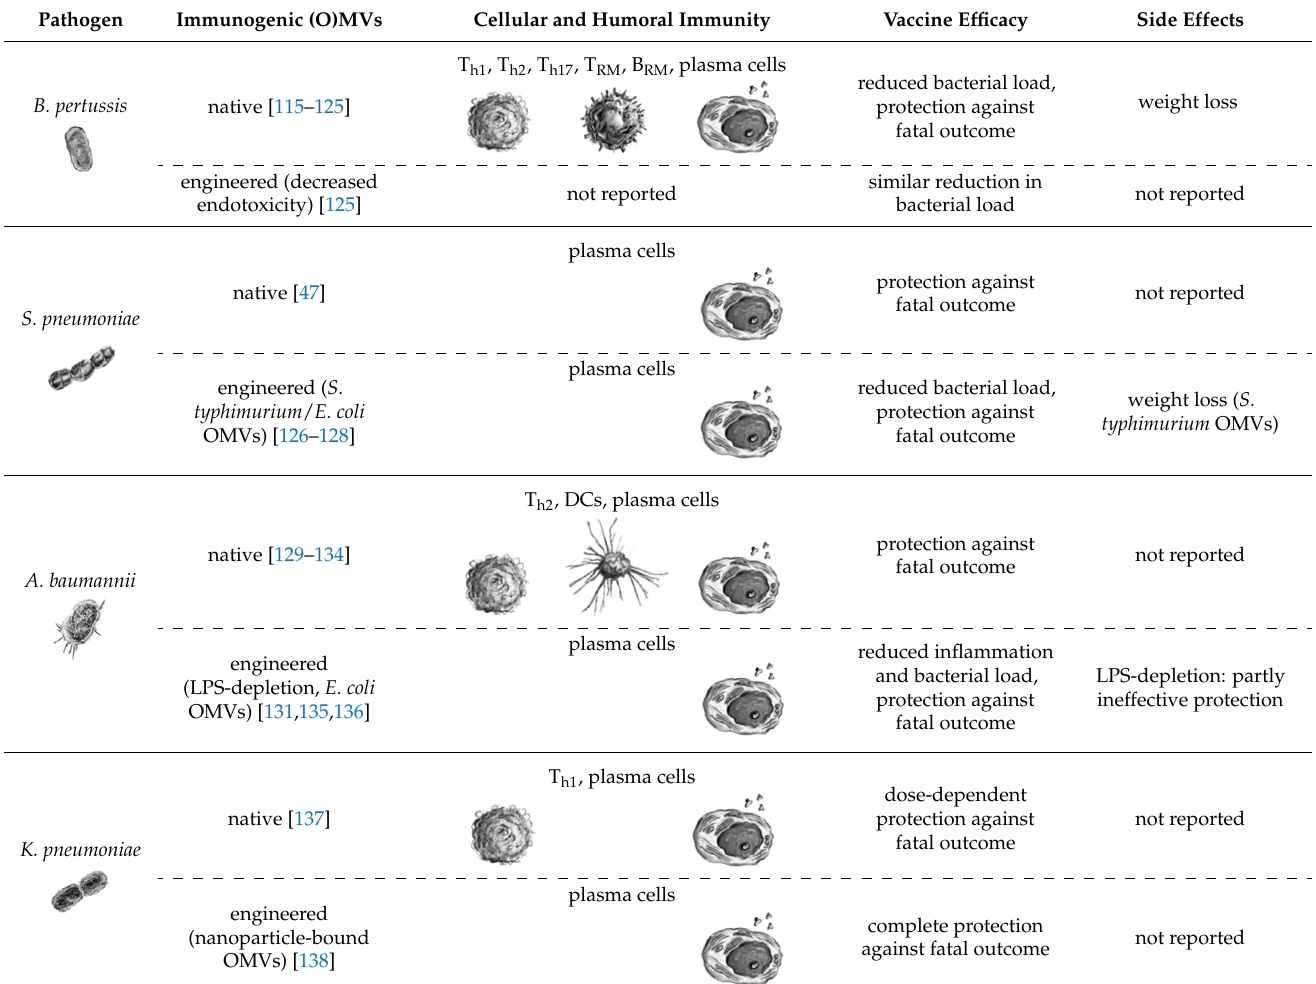
Table 2. Immunogenic properties of (O)MV vaccine candidates against bacterial pathogens causing lower respiratory tract infections.